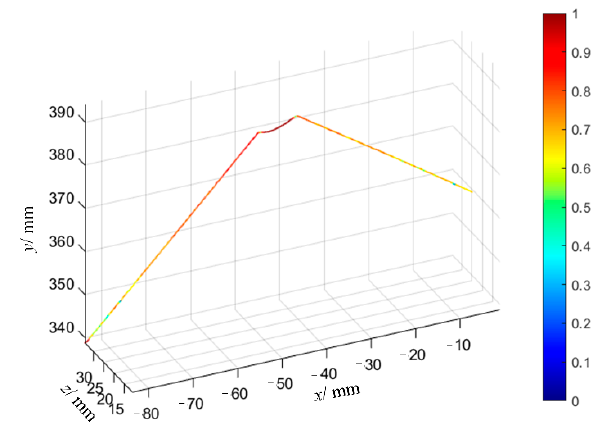
Figure 19. The point cloud data of the weldment under the welding sequence “ ②④③⑤①⑥ ”: ( a ) before welding; ( b ) after welding.